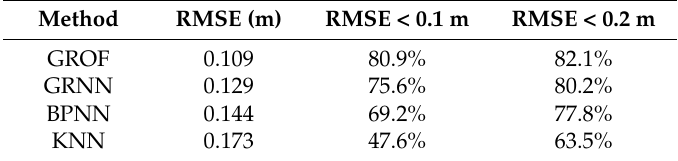
Table 4. Accuracy and precision of different algorithms in NLOS Case 1.